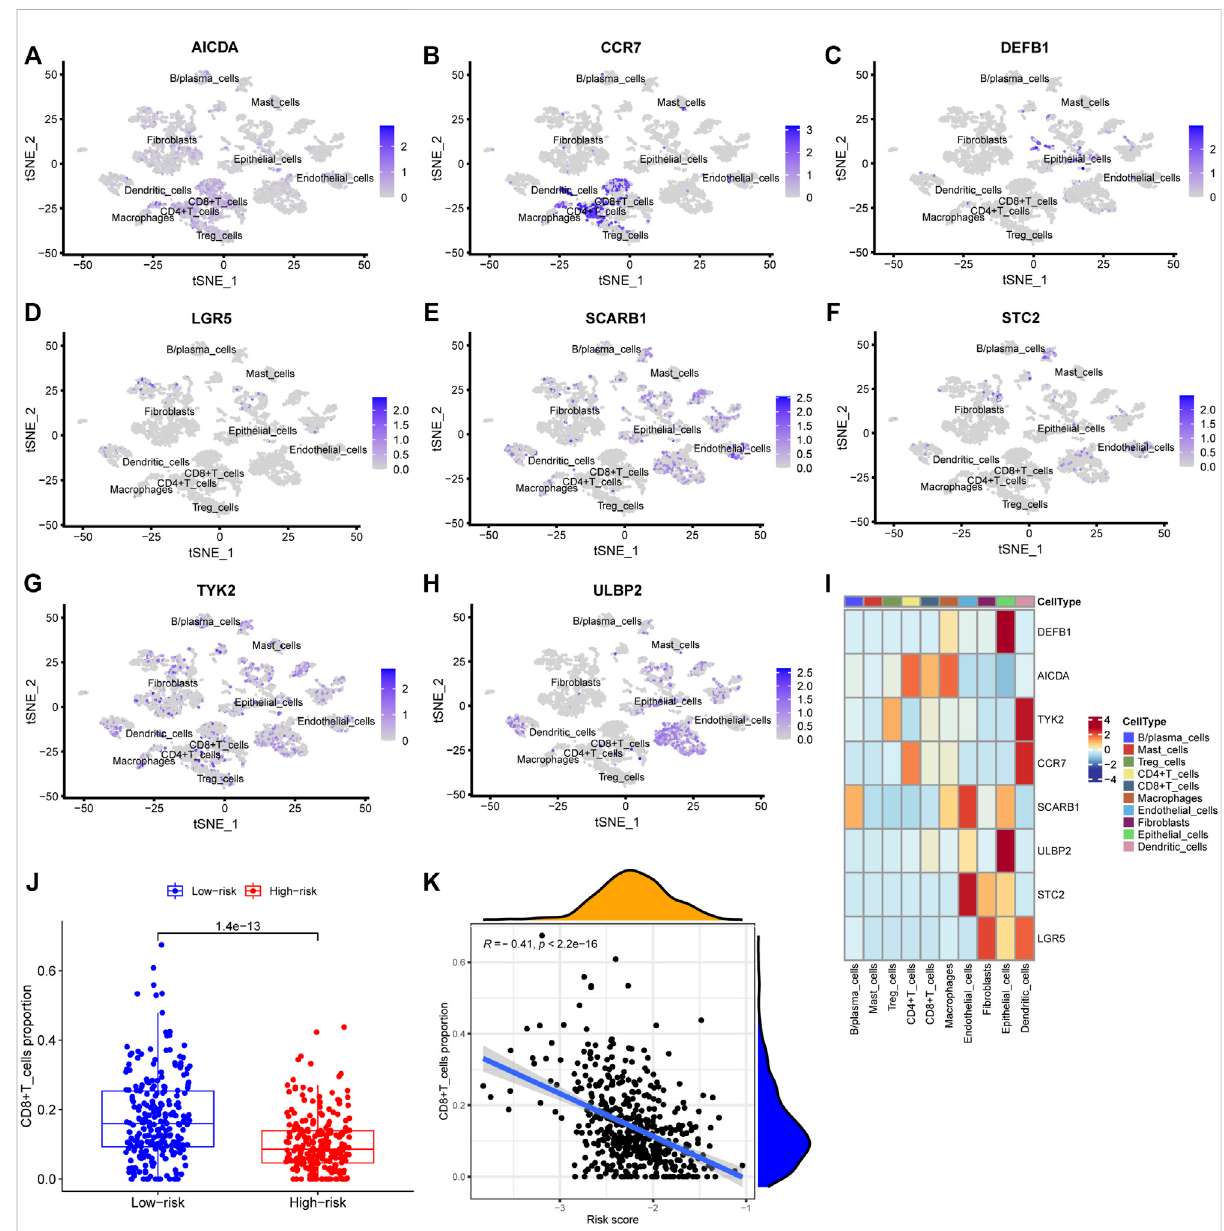
FIGURE 9 Veri fi cation using single-cell sequencing data. (A – H) Colors indicating the localization of the expression of eight genes: AICDA, CCR7, DEFB1, LGR5,SCARB1,STC2,TYK2,andULBP2. (I) Heatmapdepictingexpressionsoftheeightgenesinthecellsubtypes. (J) ThelevelsofCD8 + cellsinTCGA deconvoluteddatabetweenlow-andhigh-riskgroups( p =1.4e-13). (K) CorrelationanalysisbetweenCD8 + Tcellslevelsandriskscore(r= − 0.41, p < 2.2